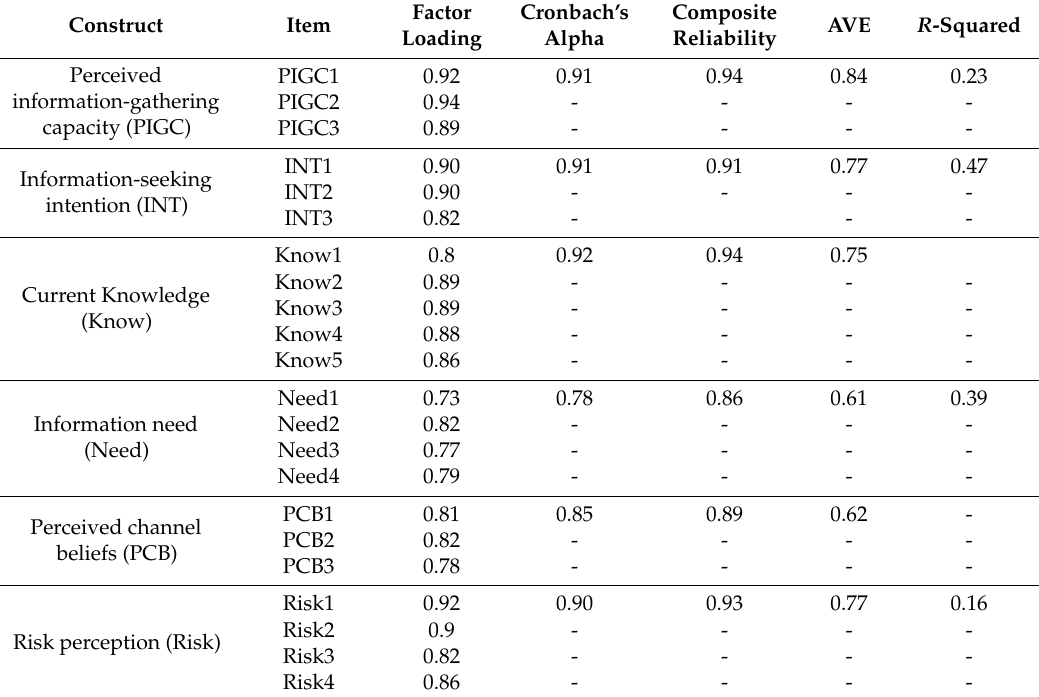
Table 2. Results of the confirmatory analysis.